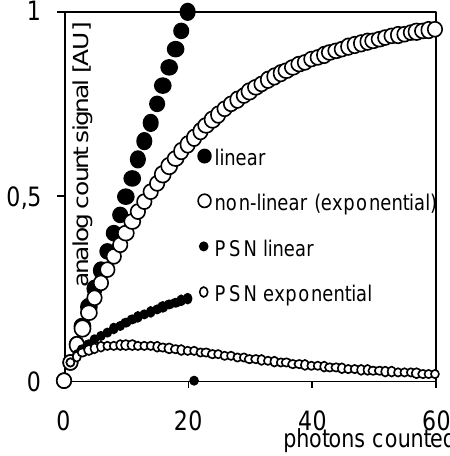
Figure 7. “Non-linear analog counting” is valid as long as the voltage step can be discriminated by the external ADC; yet this may be relaxed as long as the PSN (photon shot noise) expressed in voltage steps can be discriminated by the ADC. PSN is calculated as the square root of the number of photons